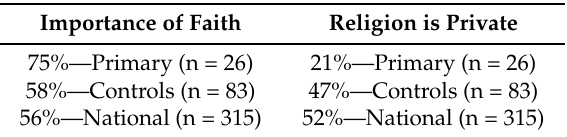
Table 1. Comparison between the primary class, control groups, and subsampled national study on the two measures with most Time 1 self-selection for the primary